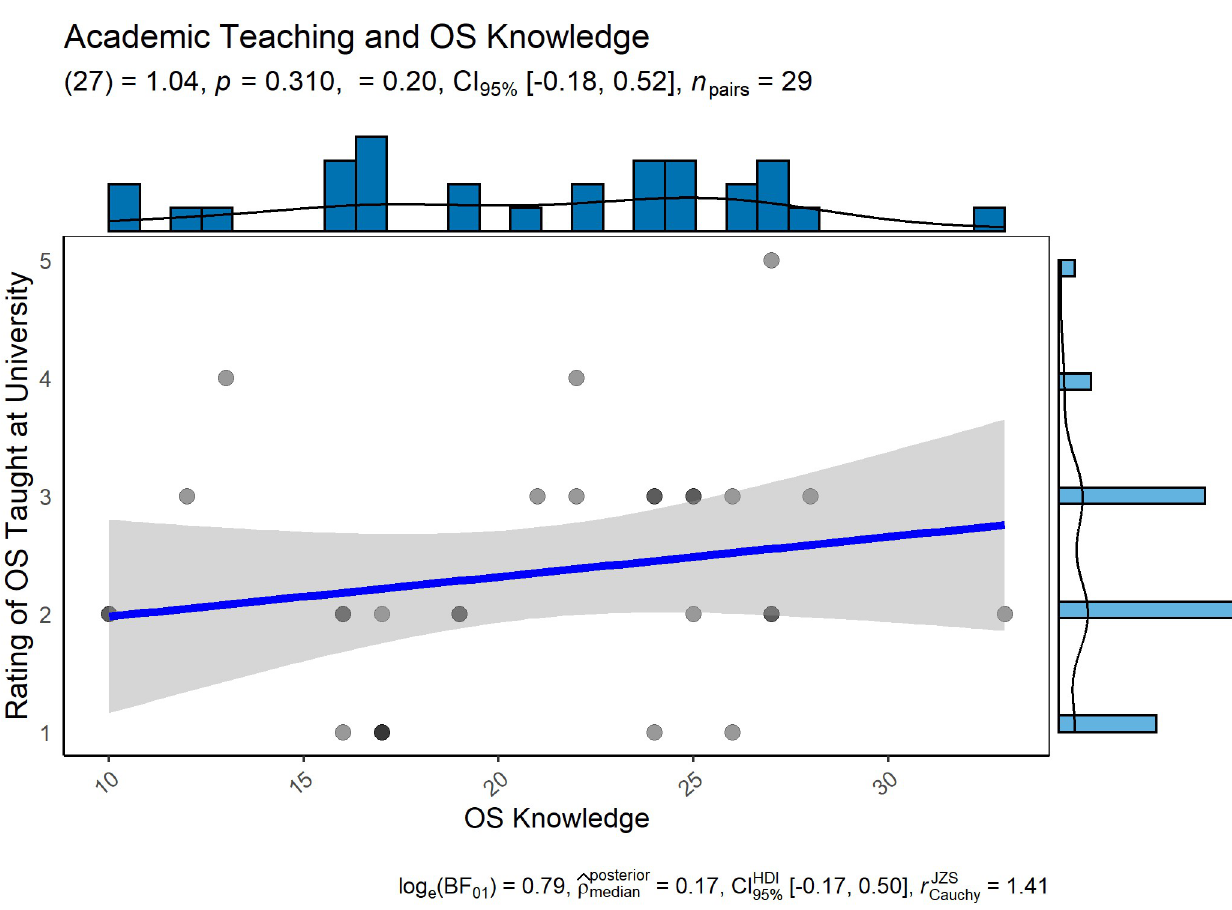
Fig 2. Correlation of OS knowledge and OS being taught at